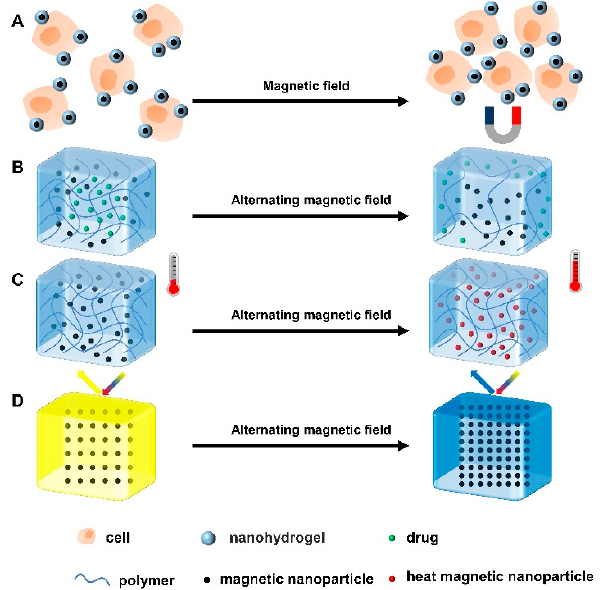
Figure 3. Four gelation mechanisms of magnetic-responsive hydrogels. ( A ) Under the influence of a magnetic field, the cells attached to the magnetic nanoparticle hydrogel clustered in a specific direction. Under the action of alternating magnetic field, ( B ) magnetic nanoparticles in hydrogels move, resulting in a decrease in crosslinking density and the release of loaded drugs. ( C ) The motion of magnetic nanoparticles generates heat, which leads to a temperature rise in the system. ( D ) Due to the magnetothermal effect, the distance between the magnetic nanoparticles decreases and the diffraction peak shifts, leading to the discoloration of the